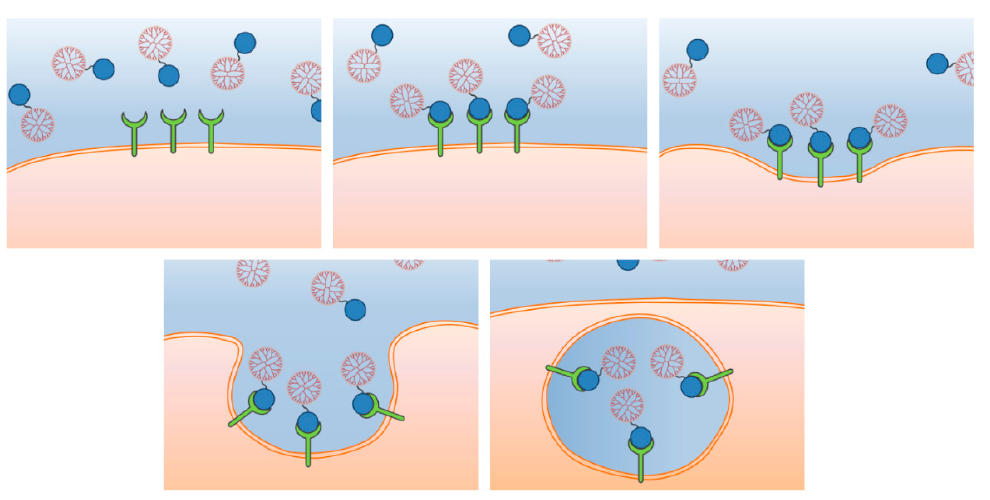
Figure 2. Receptor mediated endocytosis. A specific interaction of a ligand on the surface of a nanoparticle (NP) (in blue) with a receptor (in green) triggers the formation of an invagination on the cell membrane which finally leads to the formation of an endosome thanks to the proteins implicated in each of the different pathways.